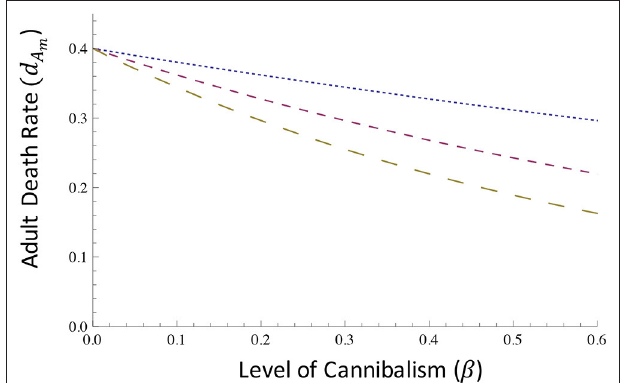
FIGURE 3 | Energetic benefits of filial cannibalism to mutant parents. Mutant parents that exhibit filial cannibalism are assumed to gain energetic benefits that reduce their mortality ( d A ). Here, we consider three levels of energetic m benefits of filial cannibalism ( γ ): low energetic benefits to parents (small dashed = d A line), such that d A * Exp [ − 0.5* β ]; medium energetic benefits to m m 0 = d A parents (medium dashed line), such that d A * Exp [ − 1* β ]; and high m m 0 energetic benefits to parents (large dashed line), such that = d A d A * Exp [ − 1.5* β ]. In all cases illustrated here, we assume that m m 0 = d A m 0